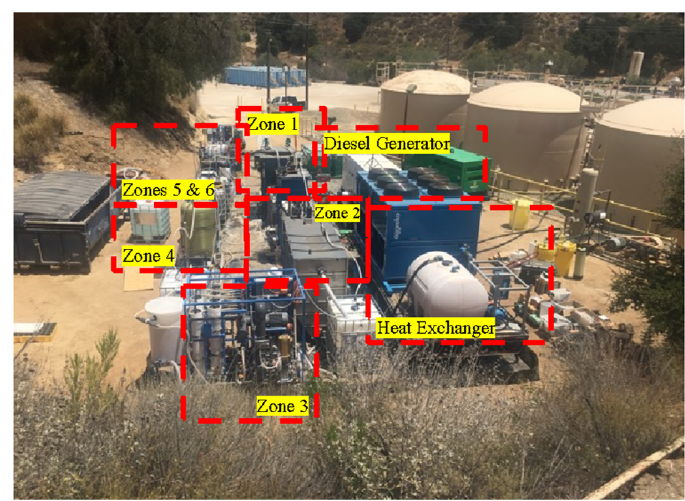
Figure 2. Process flow diagram for the pilot test system. Numbers in the figure indicate water quality sampling and process performance monitoring locations. OWS: oil–water separation; CLF: